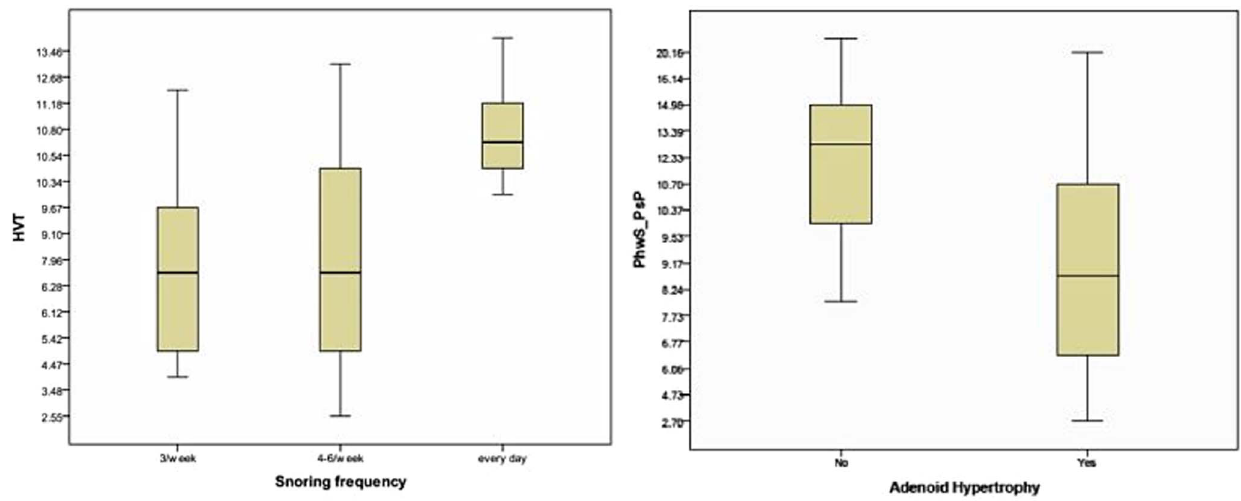
Figure 2. The vertical position of the tongue represented by H H VT in children reporting a different snoring frequency (7.3 + 2.7 vs 7.6 + 3.7 vs 10.9 + 2.5 in children snoring 3 nights/week, 4–6nights/week and every day respectively; p=0.032) and the posterior superior airway space or Phw1_PsP in children with and without adenoid hypertrophy (9.3 + 4.5 vs 17.1 + 4.6; p , 0.01). doi:10.1371/journal.pone.0111675.g002 Figure 2) and PhwN_STBn (5.8 6 2.5 vs 9.2 6 1.7; p , 0.03) while